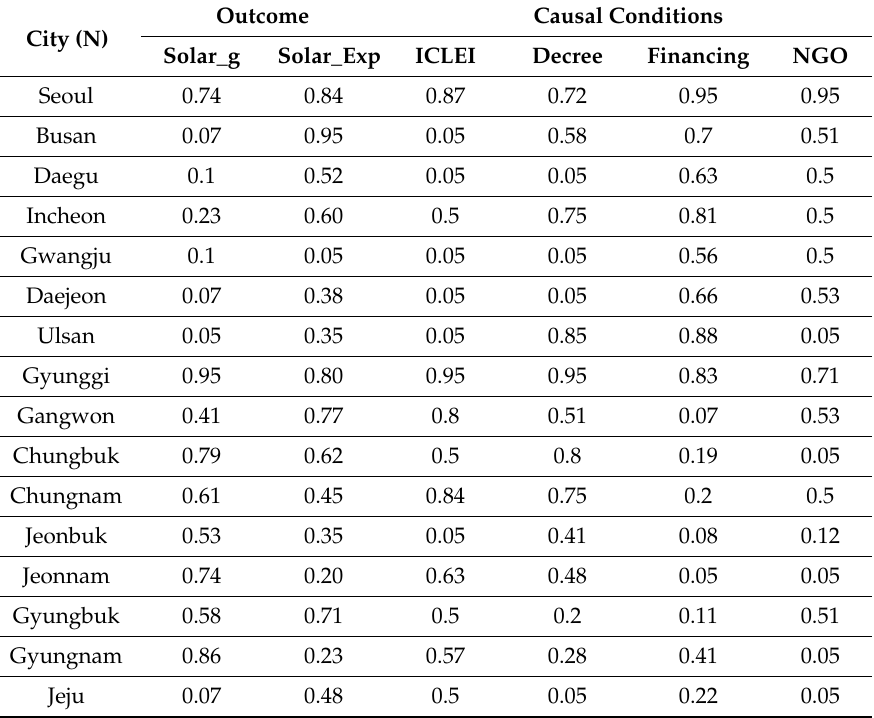
Table 1. Fuzzy scores (calibrated